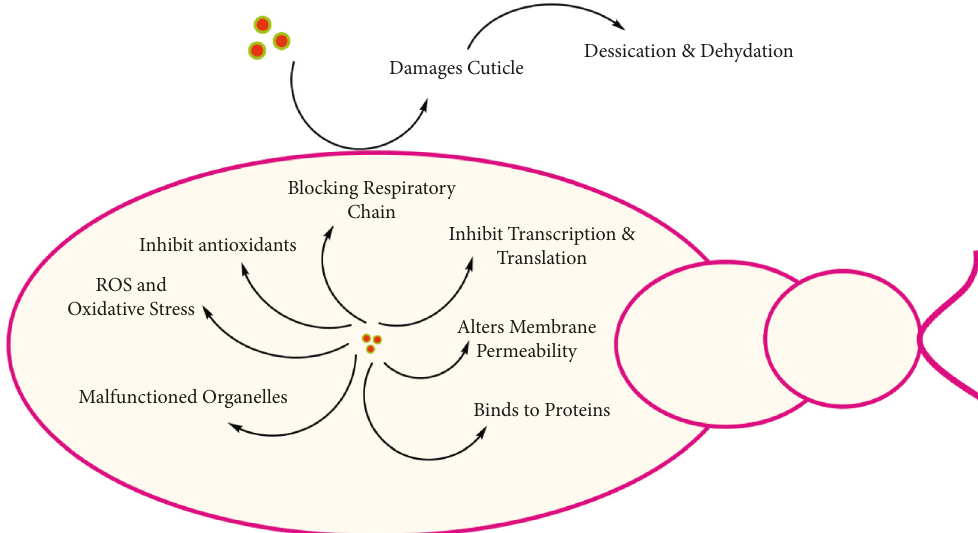
Figure 2: Mechanism of nanoparticles toxicity against